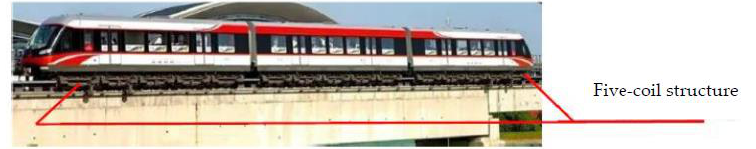
Figure 11. 160 km/h Maglev train adopting five-coil structure as end electromagnet module.